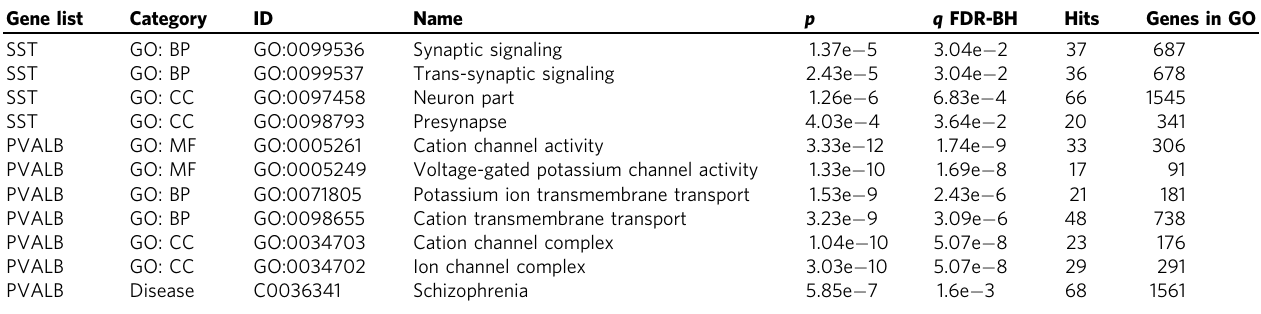
Table 1 Enrichment terms for interneuron-correlated